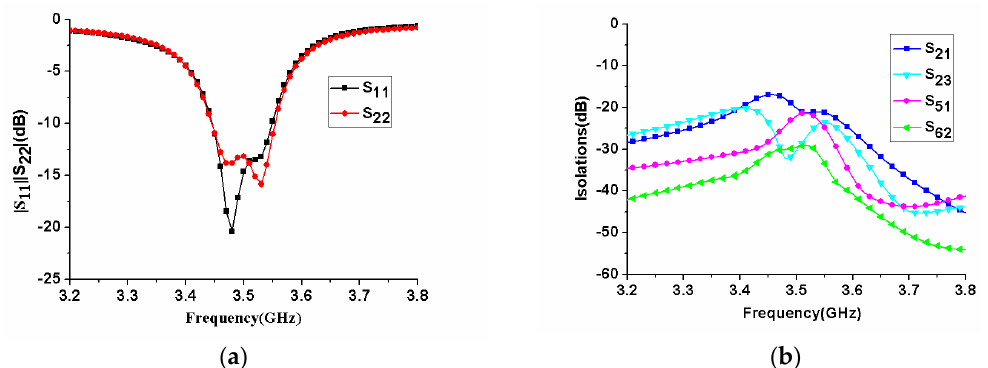
Figure 10. Simulated S-parameters of the proposed MIMO antenna array. ( a ) reflection coefficients; ( b ) isolations.